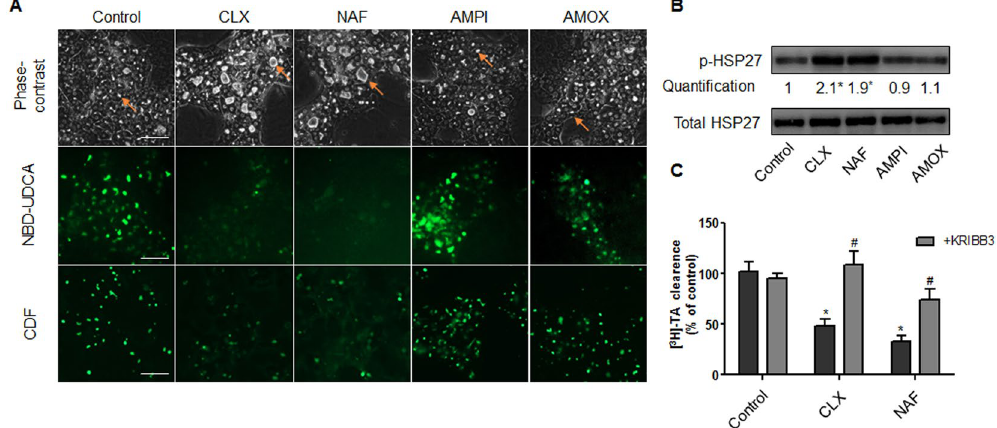
Figure 8. HSP27-dependent cholestatic effects of penicillinase-resistant antibiotics in human HepaRG cells. ( A ) Phase-contrast images, NBD-UDCA and CDF efflux in HepaRG cells either untreated or treated with 6 mM cloxacillin (CLX), nafcillin (NAF), ampicillin (AMPI) and amoxicillin (AMOX) for 2 h. Phase-contrast images were captured using time-lapse microscopy. Orange arrows indicate BC deformations. Fluorescent images were obtained with a Cellomics ArrayScan VTI HCS Reader (bar = 50 µ m). ( B ) Representative western blots of the p-HSP27/total HSP27 forms after 2h-treatment of HepaRG cells with 6 mM CLX, NAF, AMPI and AMOX. Quantification of p-HSP27 using ImageJ 1.48 software. The displayed blots were cropped and the original full- length gels are included in the supplementary information. ( C ) [ 3 H]-TA clearance in HepaRG cells treated with 6 mM CLX or NAF alone or co-treated with 0.5 µ M KRIBB3 for 2 h. Data were expressed relative to those of untreated cells arbitrarily set at a value of 1 or 100%. They represent the means ± SEM of 3 independent experiments. * p < 0.05 compared with that of untreated